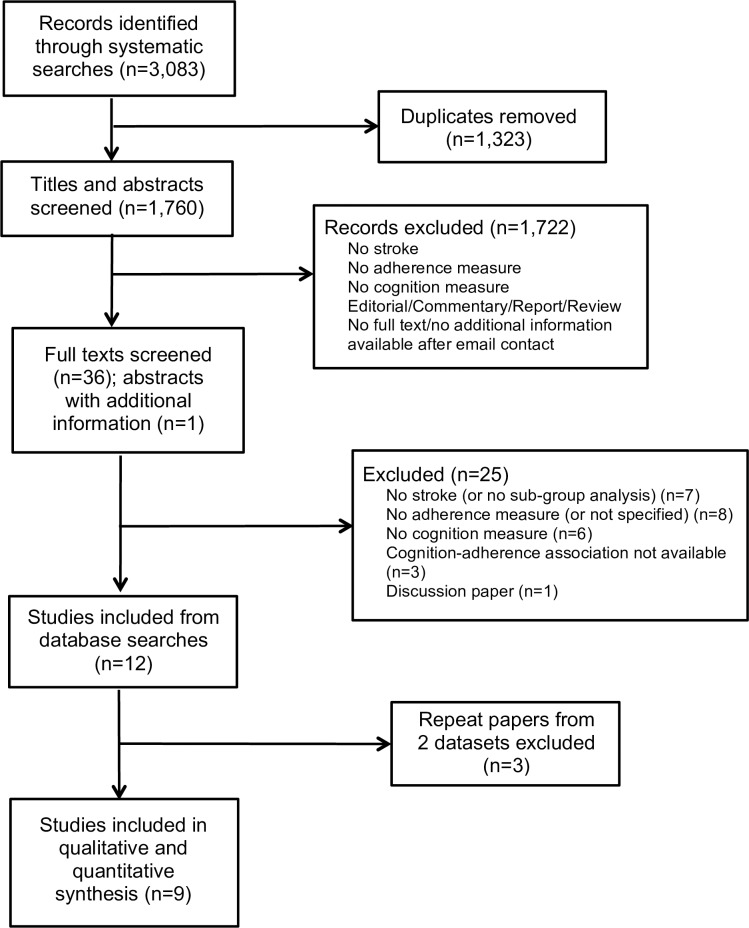
Flow chart of included studies.